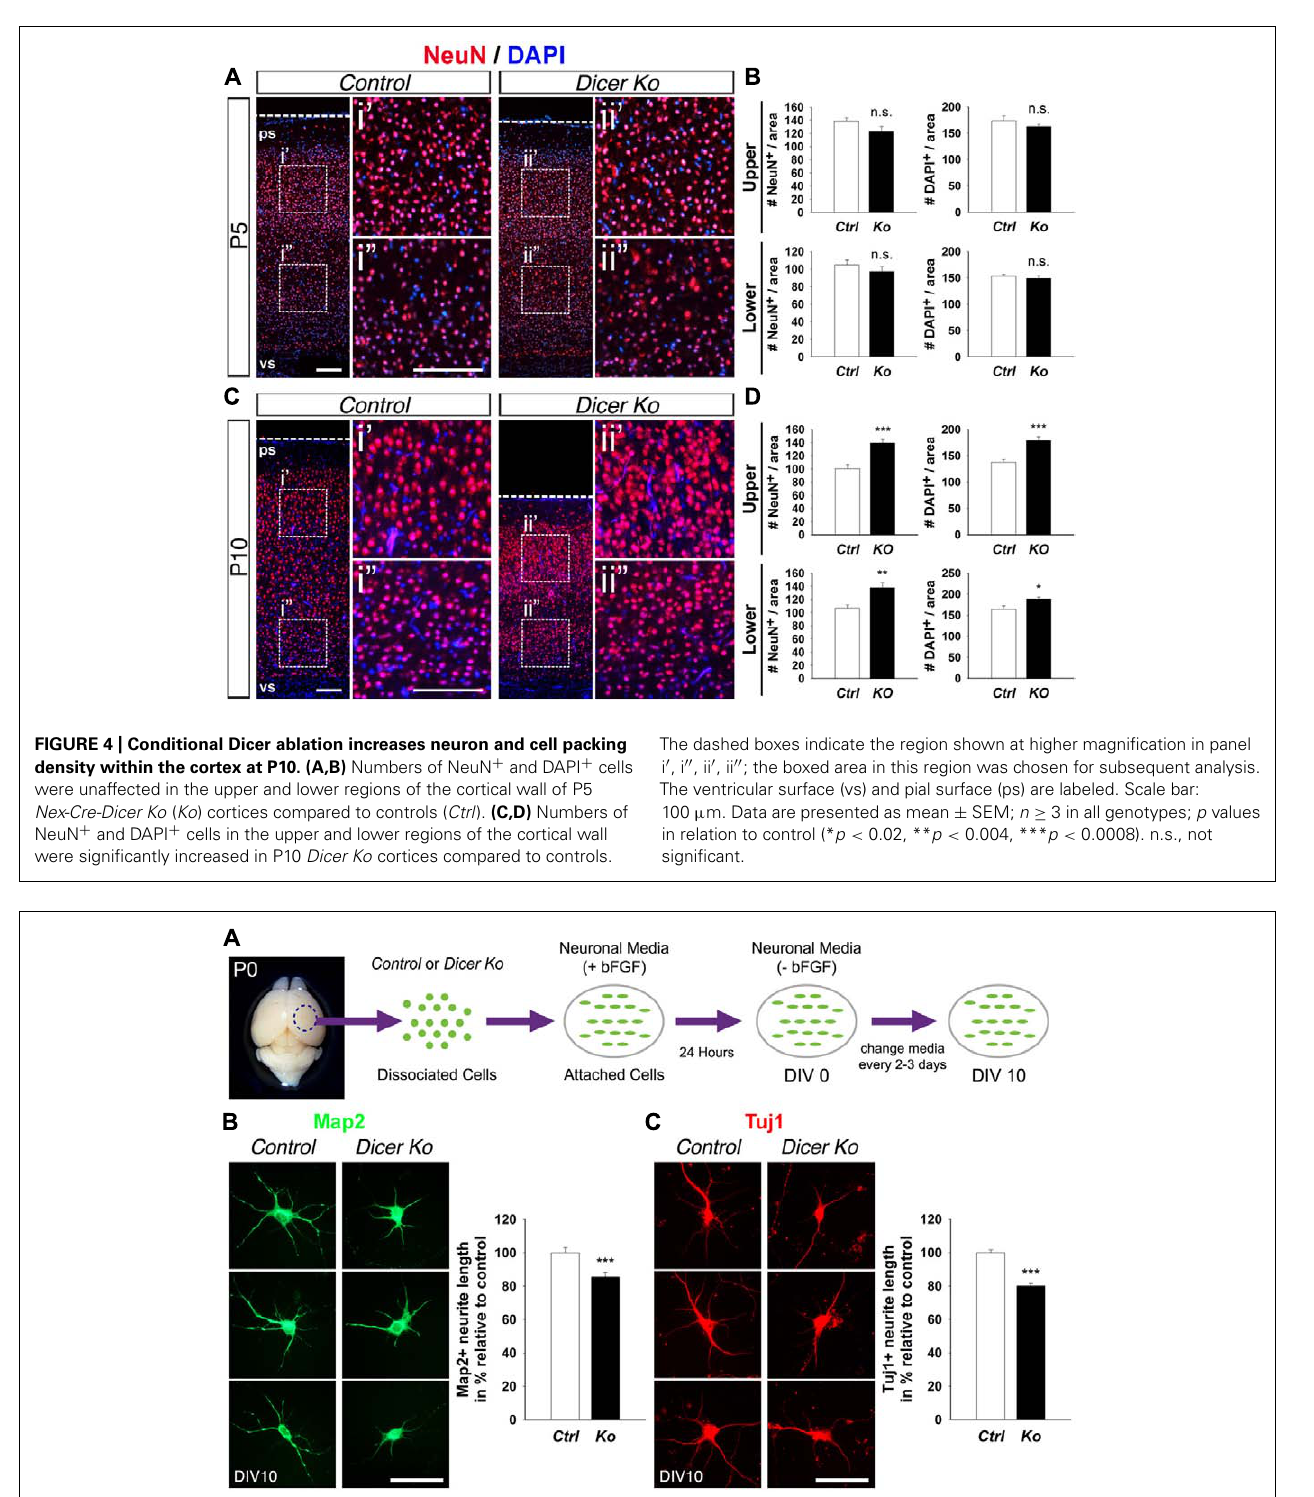
compared to controls ( N = 158). (C) Measurements ofTuj1 + processes displayed shorter neurite outgrowth in DIV 10 Dicer Ko ( N = 411) neural cultures compared to controls ( N = 423). Scale bar: 50 μ m. Data are presented as mean ± SEM; n ≥ 3 in all genotypes; p values in relation to control (*** p <